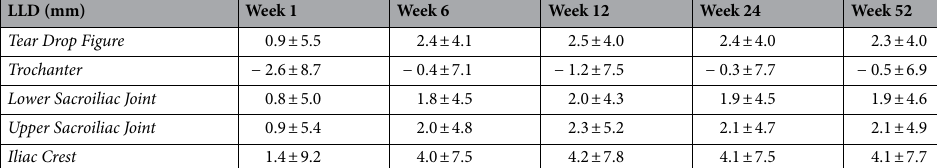
Table 2. Postoperative LLD measurements (in mm) at different time points as assessed on distinct anatomical landmarks (based on 2349 measurements (depicting the mean of the two observer’s